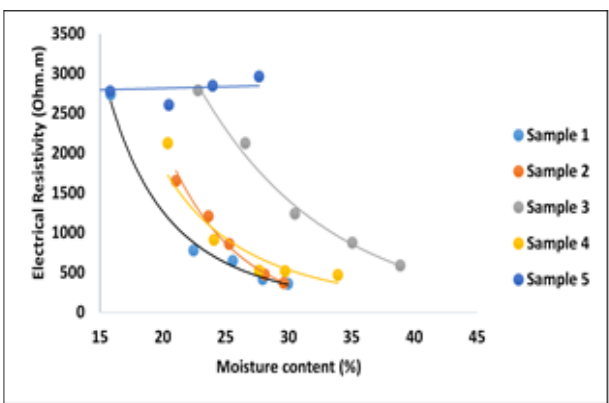
Fig. 7. Relationship between MC and LER for the 1 st 5 samples